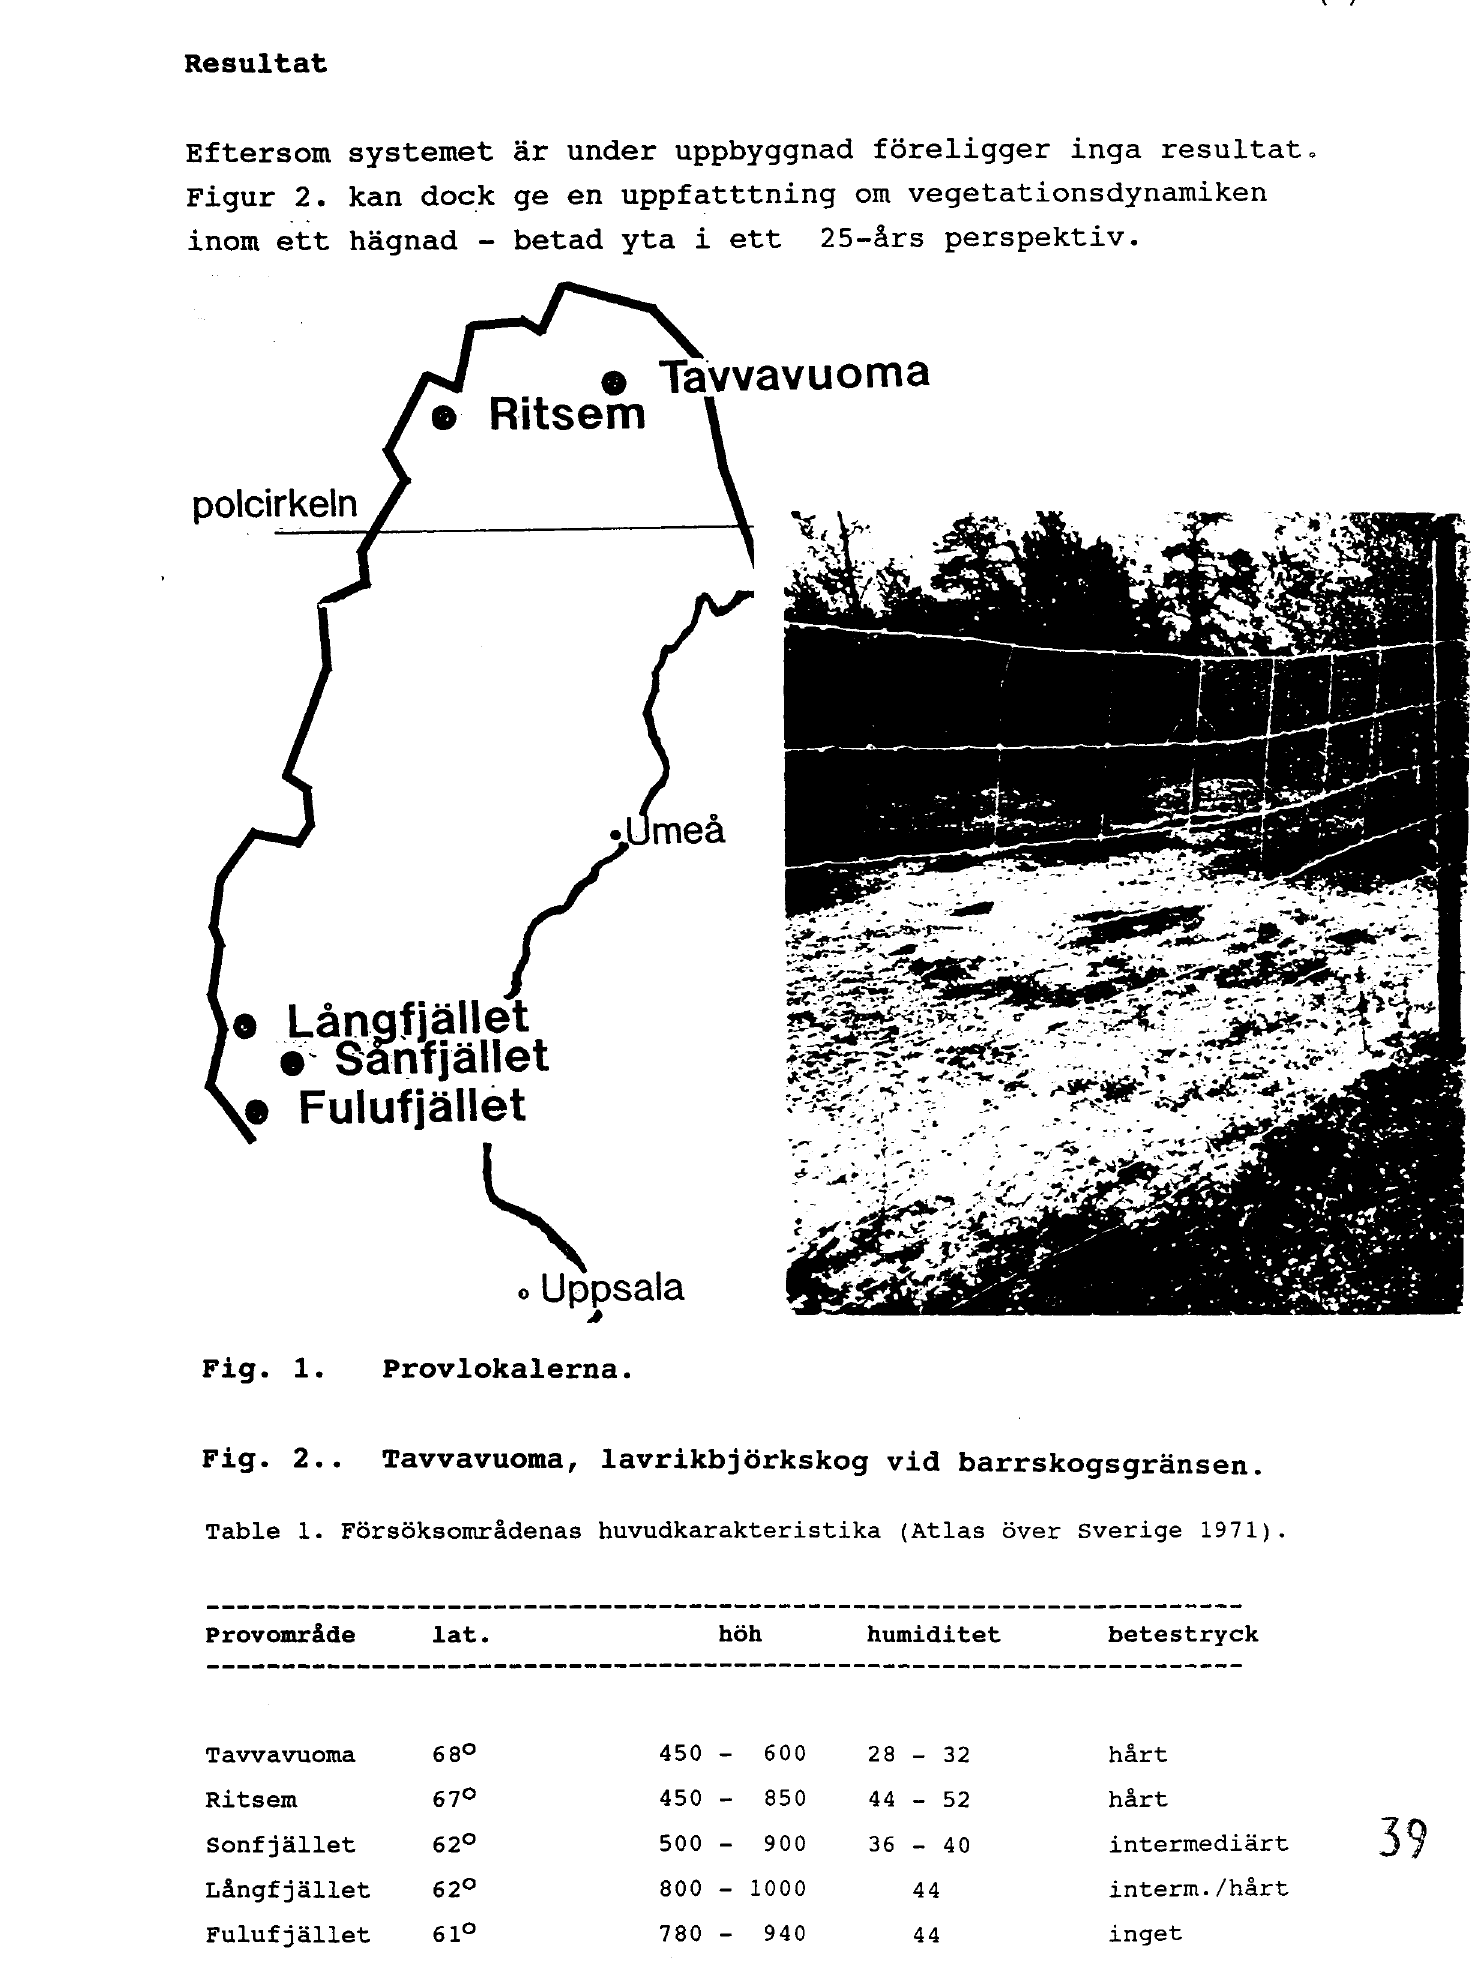
1. Provlokalerna. 2.. Table 1. Forsoksområdenas huvudkarakteristika (Atlas over Sverige 1971).